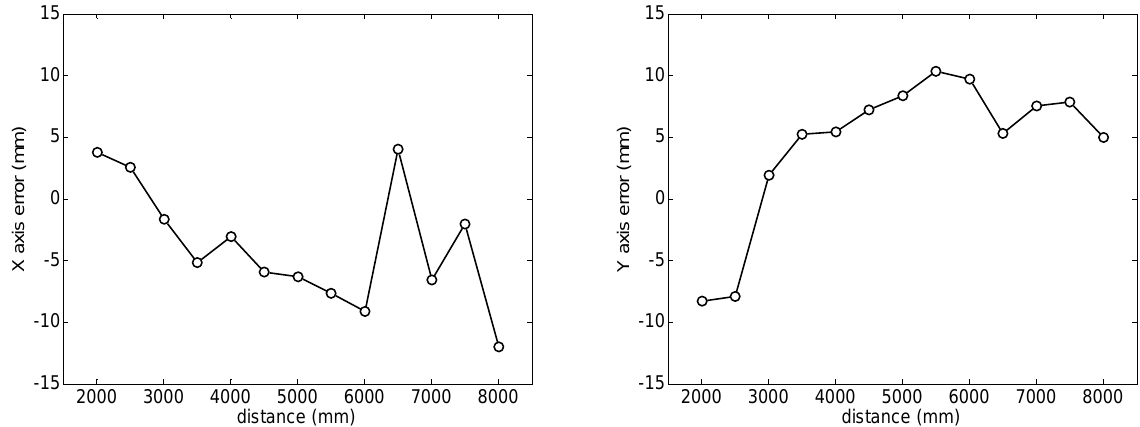
Figure 8. Evolution of the systematic absolute error of the averaged estimated position of the centre of the legs relative to the distance.